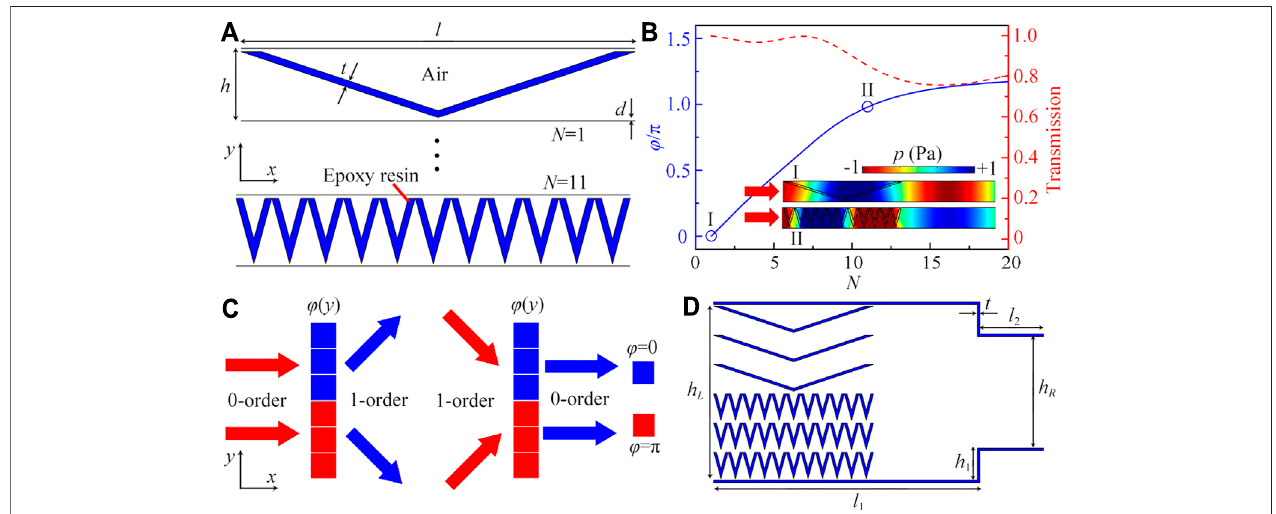
FIGURE 1 | (A) Schematic of the unit cells composed different number ( N ) of V-shaped structures. The total length l of each unit cell is the same, and the opening angle of the V-shaped structure is determined by the values N . (B) Transmission spectrum and phase delays of the unit cell as the function of N at 7.1 kHz, which are displayedasreddashedlineandbluesolidline,respectively.TwoinsetsarethepressuredistributionscreatedbytheunitcellsIandII. (C) Schematicofmodeconversion of sound created by a phased unit composed of 6 unit cells (I and II). Red and blue solid arrows are the incident and transmitted acousitc waves, respectively. (D) Schematic of a mode-conversion phased